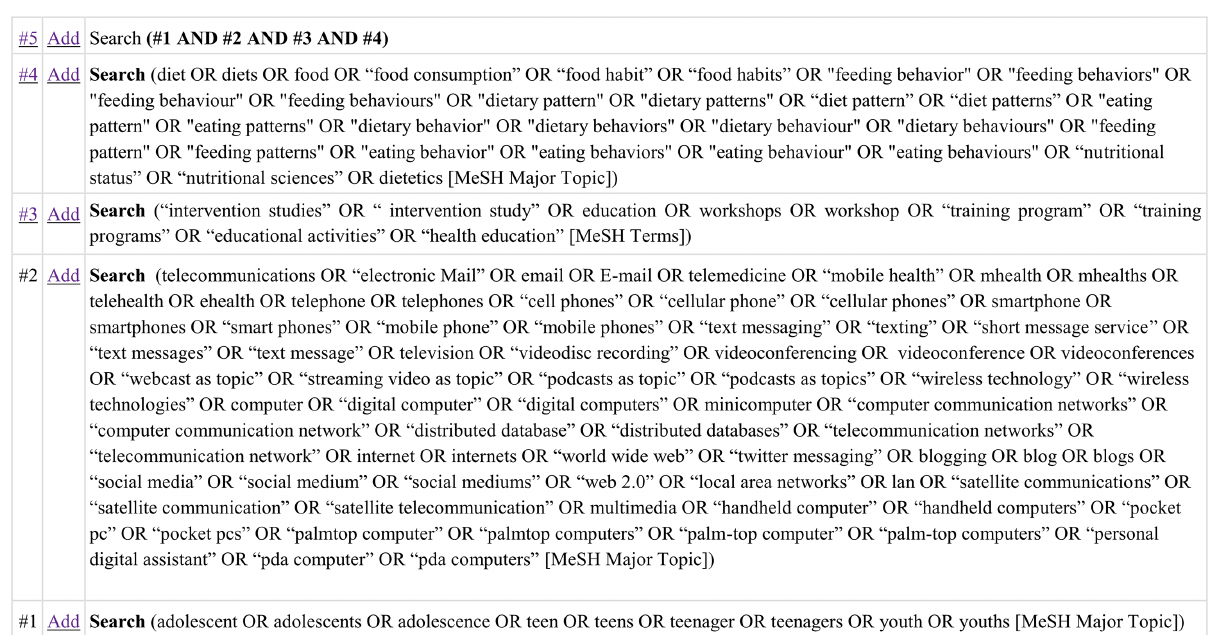
Fig 2. Retrieval and inclusion/exclusion process for articles used in